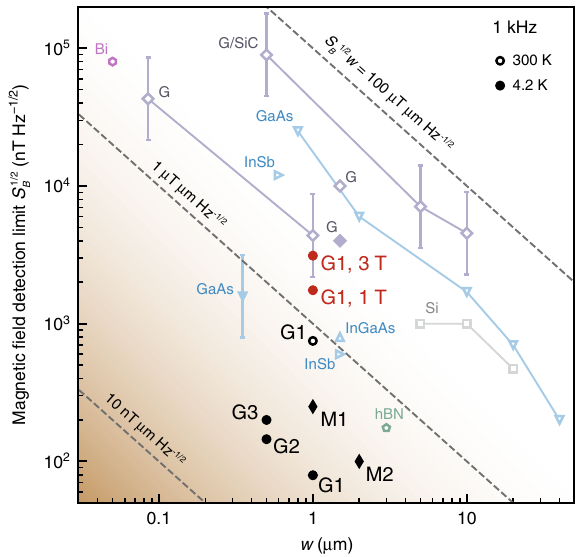
Fig. 1 Performance of micrometer-scale Hall sensors. Minimum magnetic fi eld detection limit S B 1/2 at 1 kHz vs. the width w of Hall sensors reported here and in the literature. The black markers show the best performance of our graphite-gated (circles; G1 – G3) and metal-gated (diamonds; M1 and M2) devices in zero background magnetic fi eld, and the red circles show the performance of G1 in 1 T and 3 T background fi eld as indicated. All other markers are estimates of the best performance in zero background fi eld of devices made from semiconductor- and graphene-based structures, including graphene grown by chemical vapor deposition ( “ G ” ), epitaxial graphene ( “ G/SiC ” ), and hBN-encapsulated exfoliated graphene ( “ hBN ” ). Filled (open) markers correspond to measurements at 4.2 K (300 K). Solid lines are a guide to the eye connecting markers corresponding to the same material and fabrication process. Dashed lines mark constant S B 1/2 w . Markers with error bars are extrapolated from measurements reported at different frequencies, assuming the noise is dominated by 1/ f noise and scales as f − α (error bars mark the range 0.4 < α <